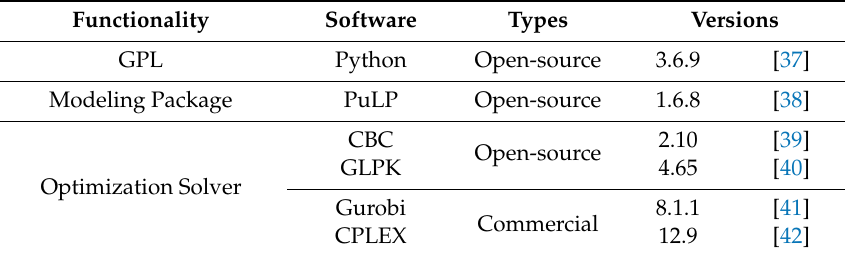
Figure 7. Forecasting load demand and photovoltaic (PV) generation power profile. Table 5. Detailed specifications of the implementation environment.